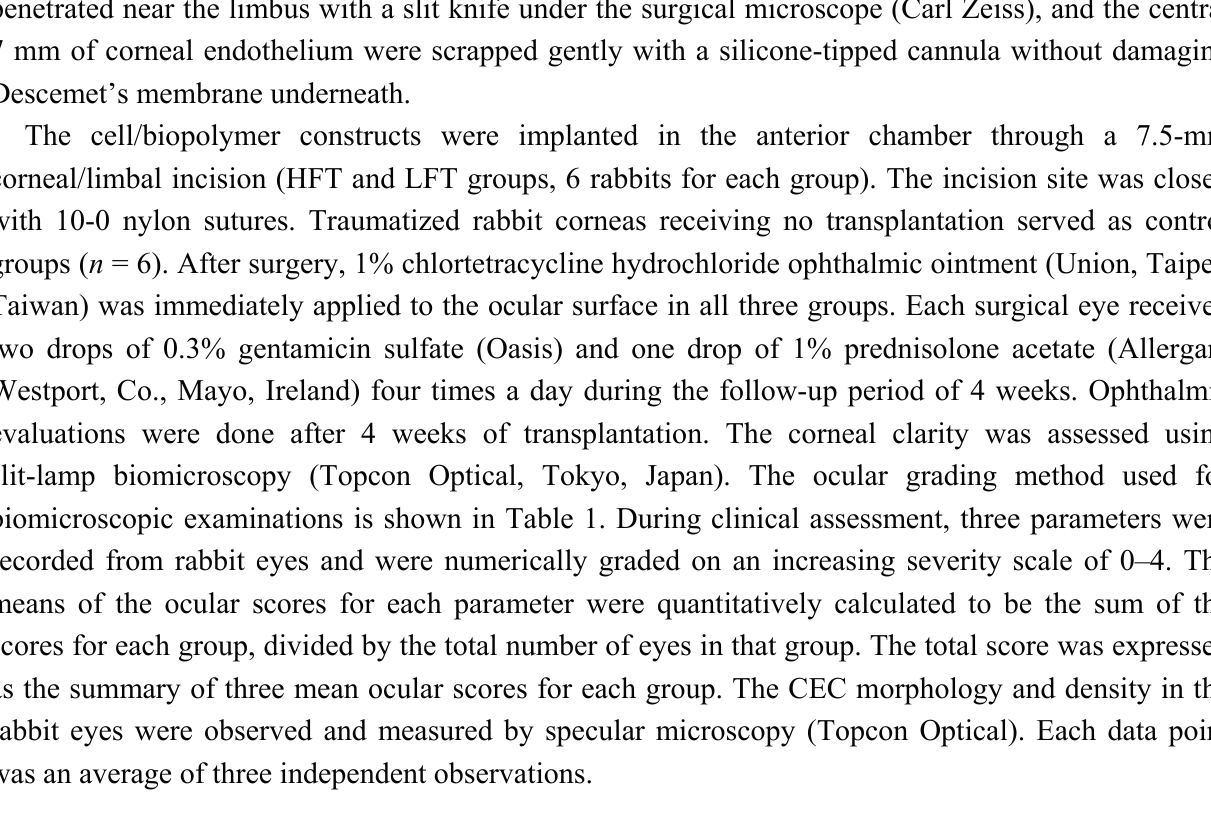
Table 1. Ocular grading system used for biomicroscopic